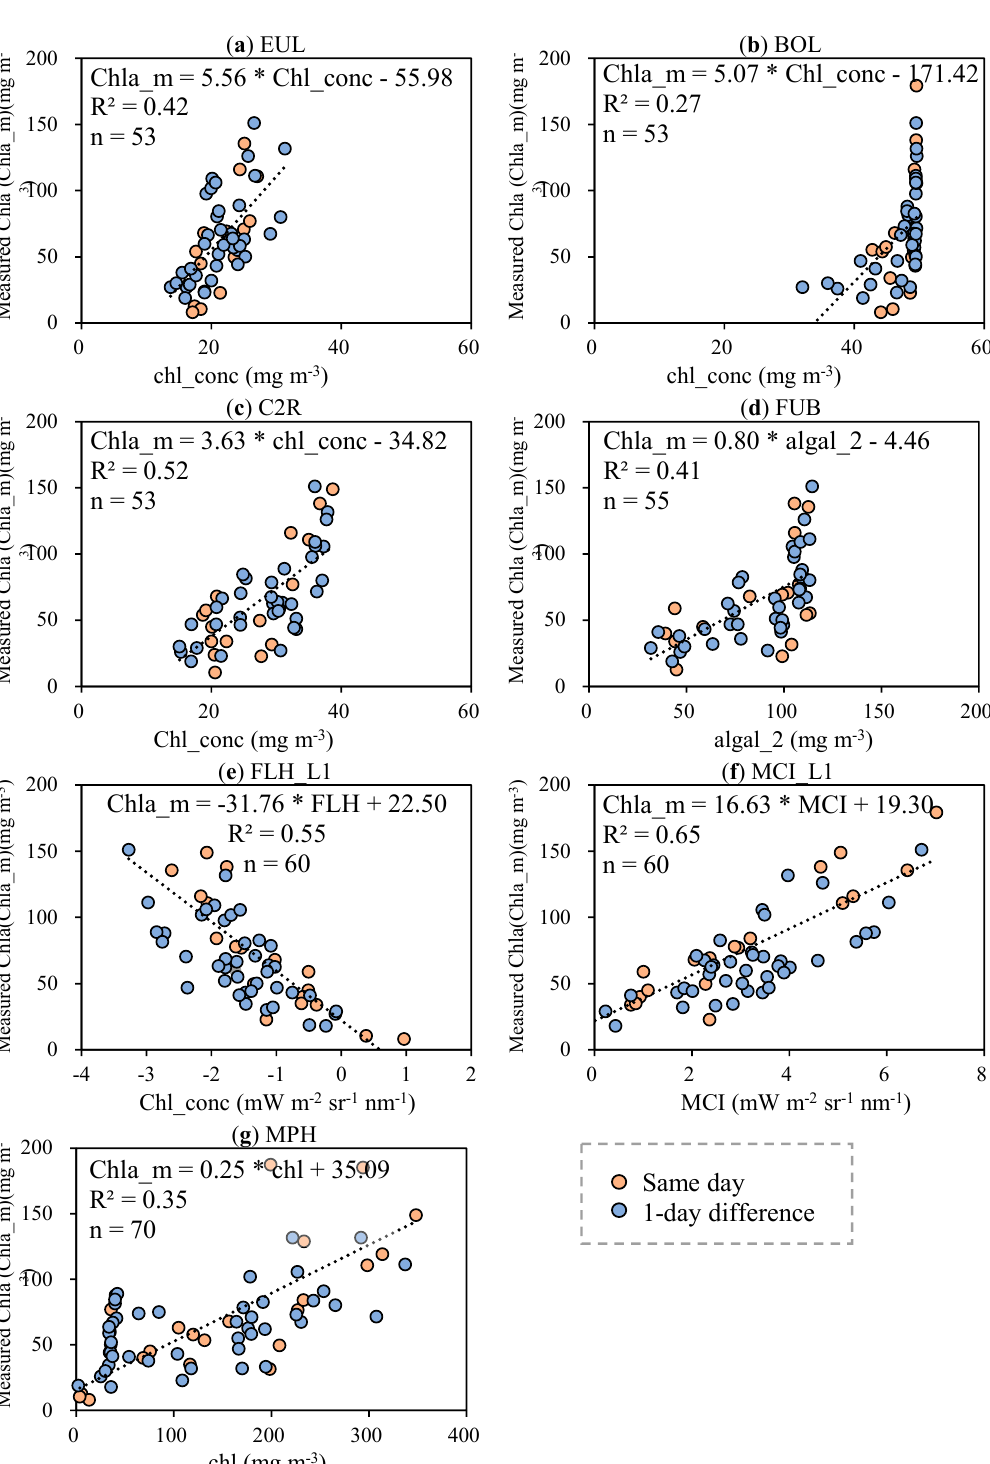
Figure 6. Calibration of ( a ) EUL; ( b ) BOL; ( c ) C2R; ( d ) FUB; ( e ) FLH; ( f ) MCI; and ( g ) MPH processors. chl_conc indicates the chlorophyll-a (Chla) concentration retrieved from EUL, BOL, and C2R processors; algal_2, and chl stand for the retrieved Chla of FUB and MPH processors; FLH and MCI denote indices correlated with Chla concentrations; and n symbolizes the number of samples used during the calibration stage (n represents 70% of total match-ups available for each processor).